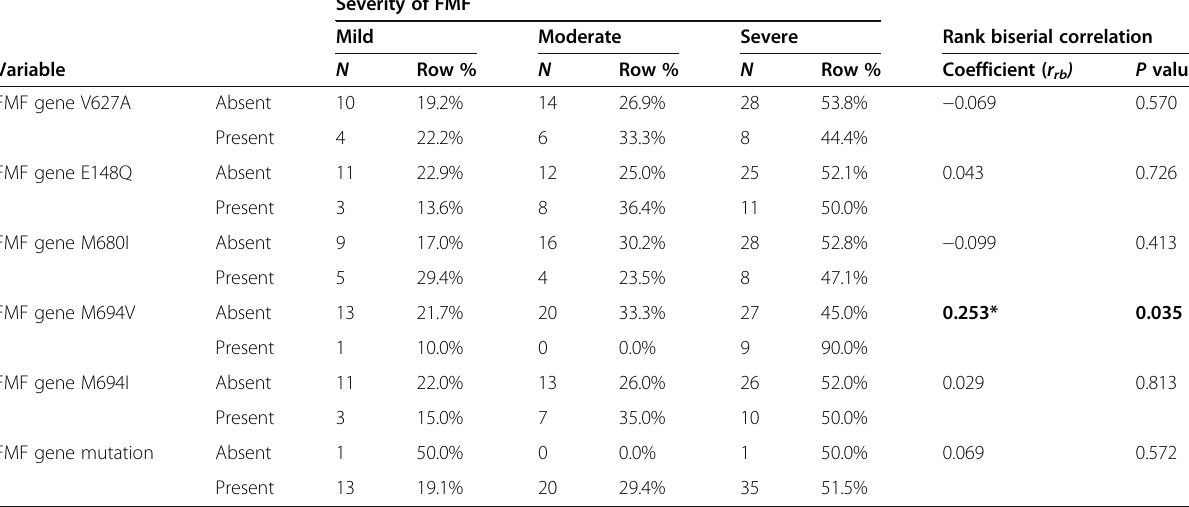
Table 4 Association between FMF genes present in study subjects and FMF disease severity Severity of FMF Mild Moderate Severe Rank biserial correlation Variable